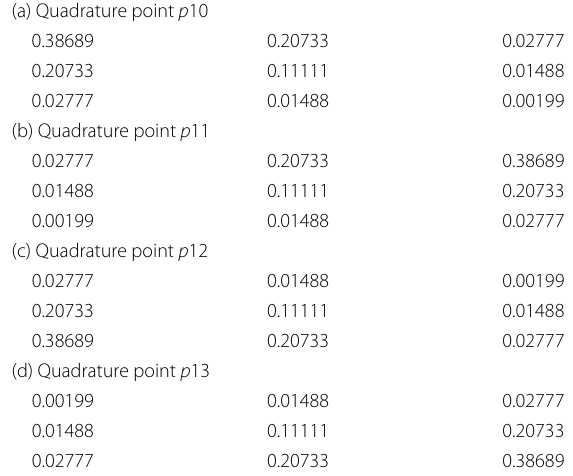
Table 1 Example single patch: shape function values N i ( ξ , η ) for each quadrature point (see Fig.